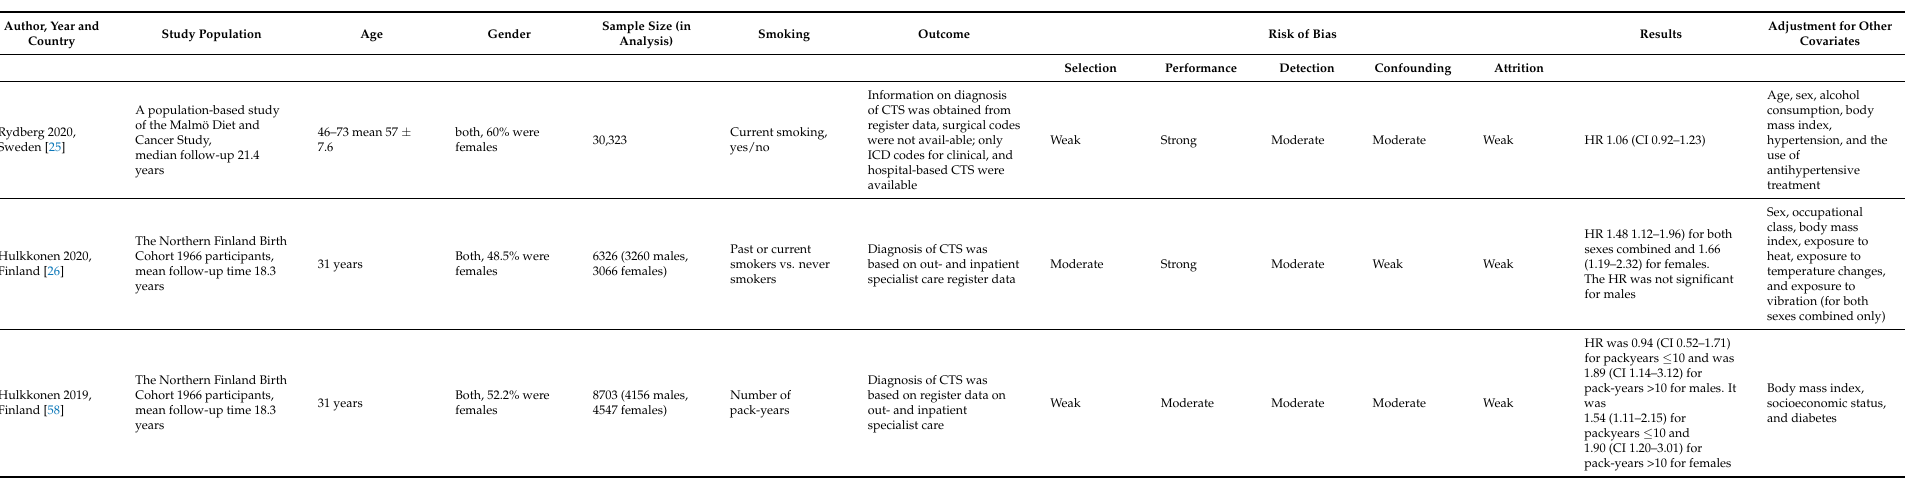
Table A4. Cohort studies included in the